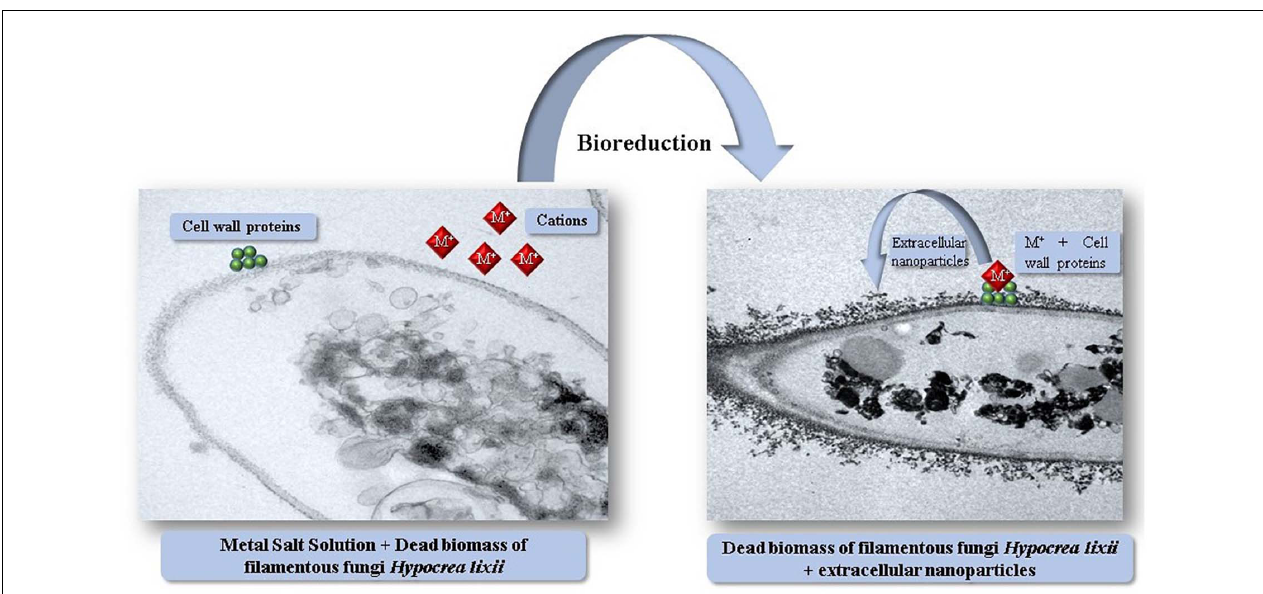
FIGURE 2 | Illustration of the mechanism of extracellular synthesis of metal nanoparticles by dead biomass of Hypocrea